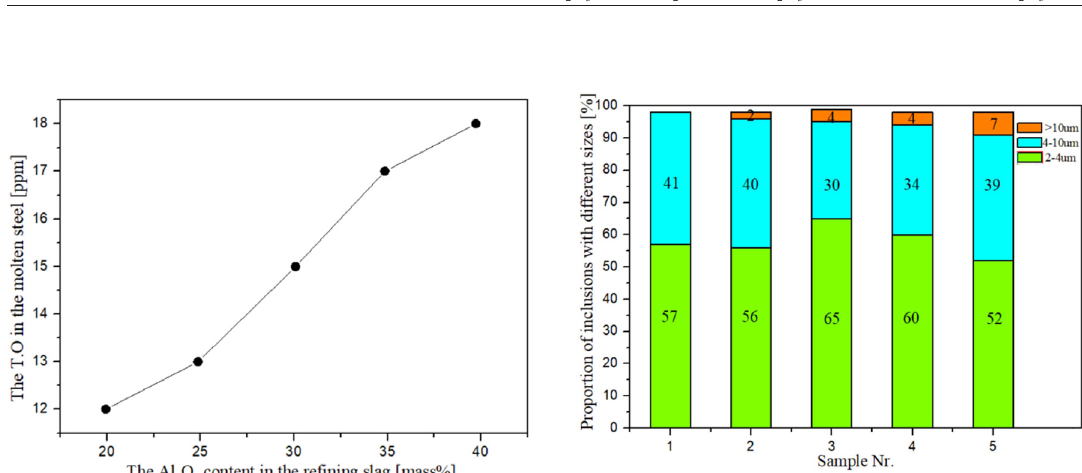
O in refining slag and T.O 2 3